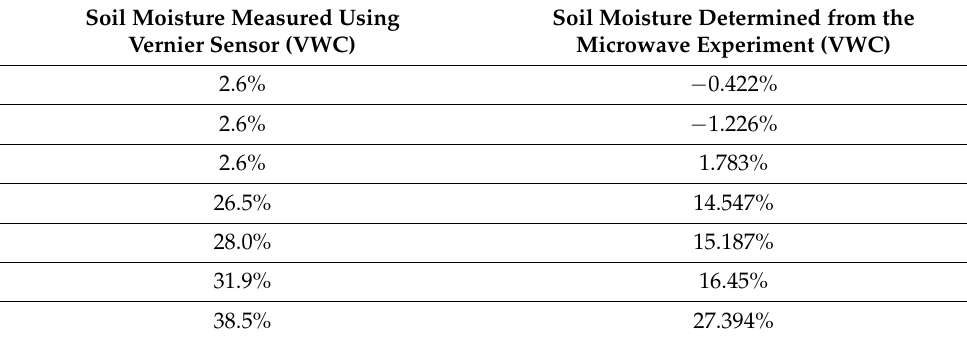
Table 2. Comparison of soil moisture values for the beach soil from